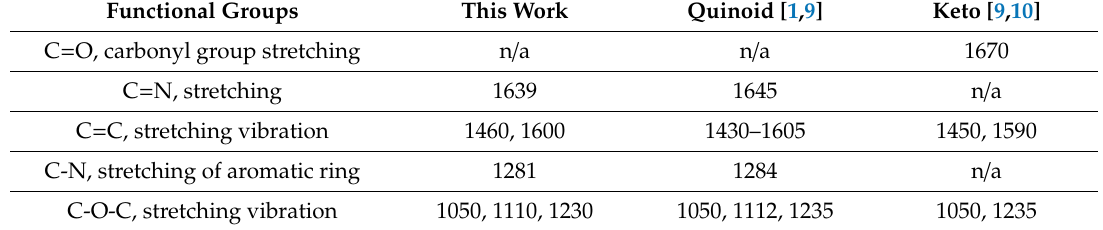
Figure 3. FTIR spectrum of oAP before ( left ) and after ( right ) the plasma treatment.